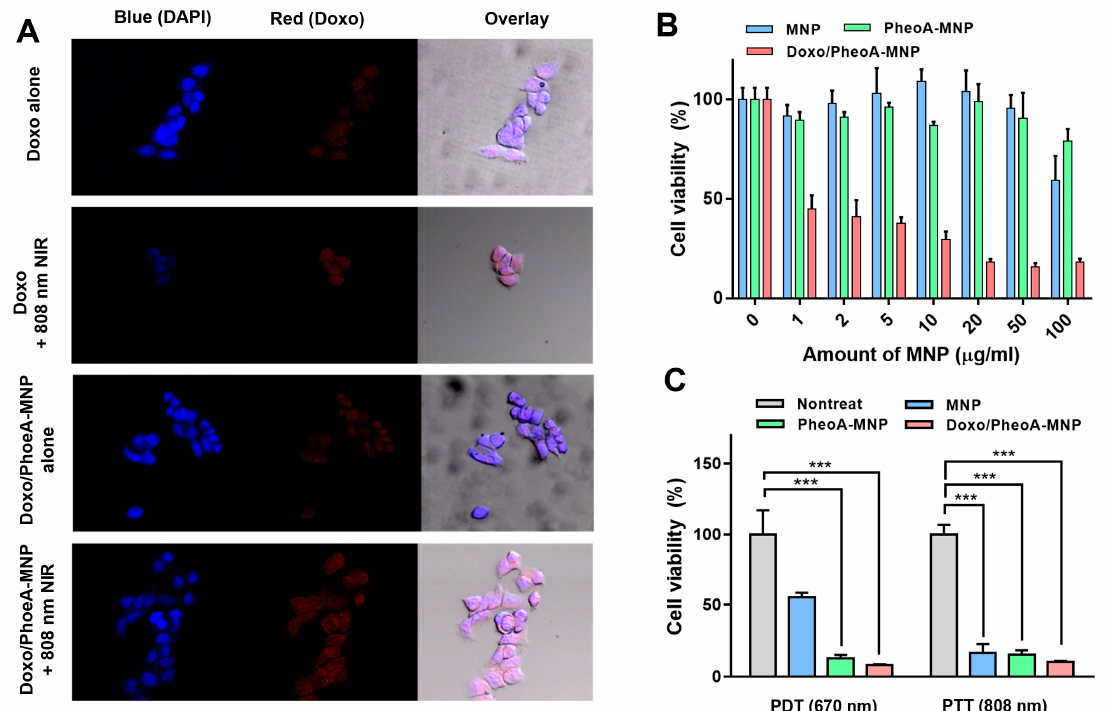
Figure 5. ( A ) Confocal laser scanning microscope (CLSM) images of HCT 116 cells treated with free Dox or Doxo/PheoA-MNPs in the absence or presence of light irradiation (808 nm). ( B ) Cell viability of HCT 116 cells treated with different concentration of MNPs, PheoA-MNPs and Doxo/PheoA-MNPs without laser irradiation. ( C ) Cell viability of HCT 116 cells treated with MNPs, PheoA-MNPs and Doxo/PheoA-MNPs under PDT (670 nm, 150mW/cm 2 for 5 min) and photothermal therapy (PTT) (808 nm, 1.2 W/cm 2 for 5 min). *** p < 0.001 by Student’s t -test ( n = 5 in each group).